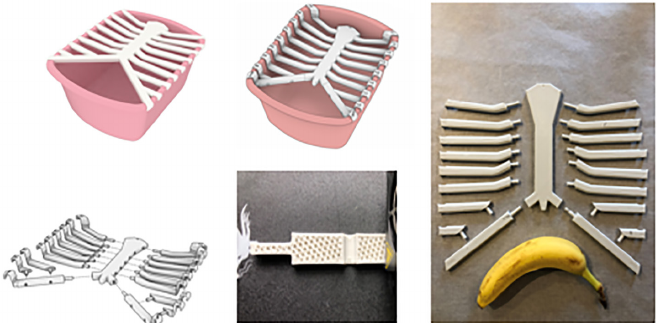
Figure 2 . Clockwise: Blind approach pericardiocentesis anterior chest model; ultrasound-guided pericardiocentesis rendering; de- atomized model with scale; cross-section of printing lattice; and de-atomized rendering.